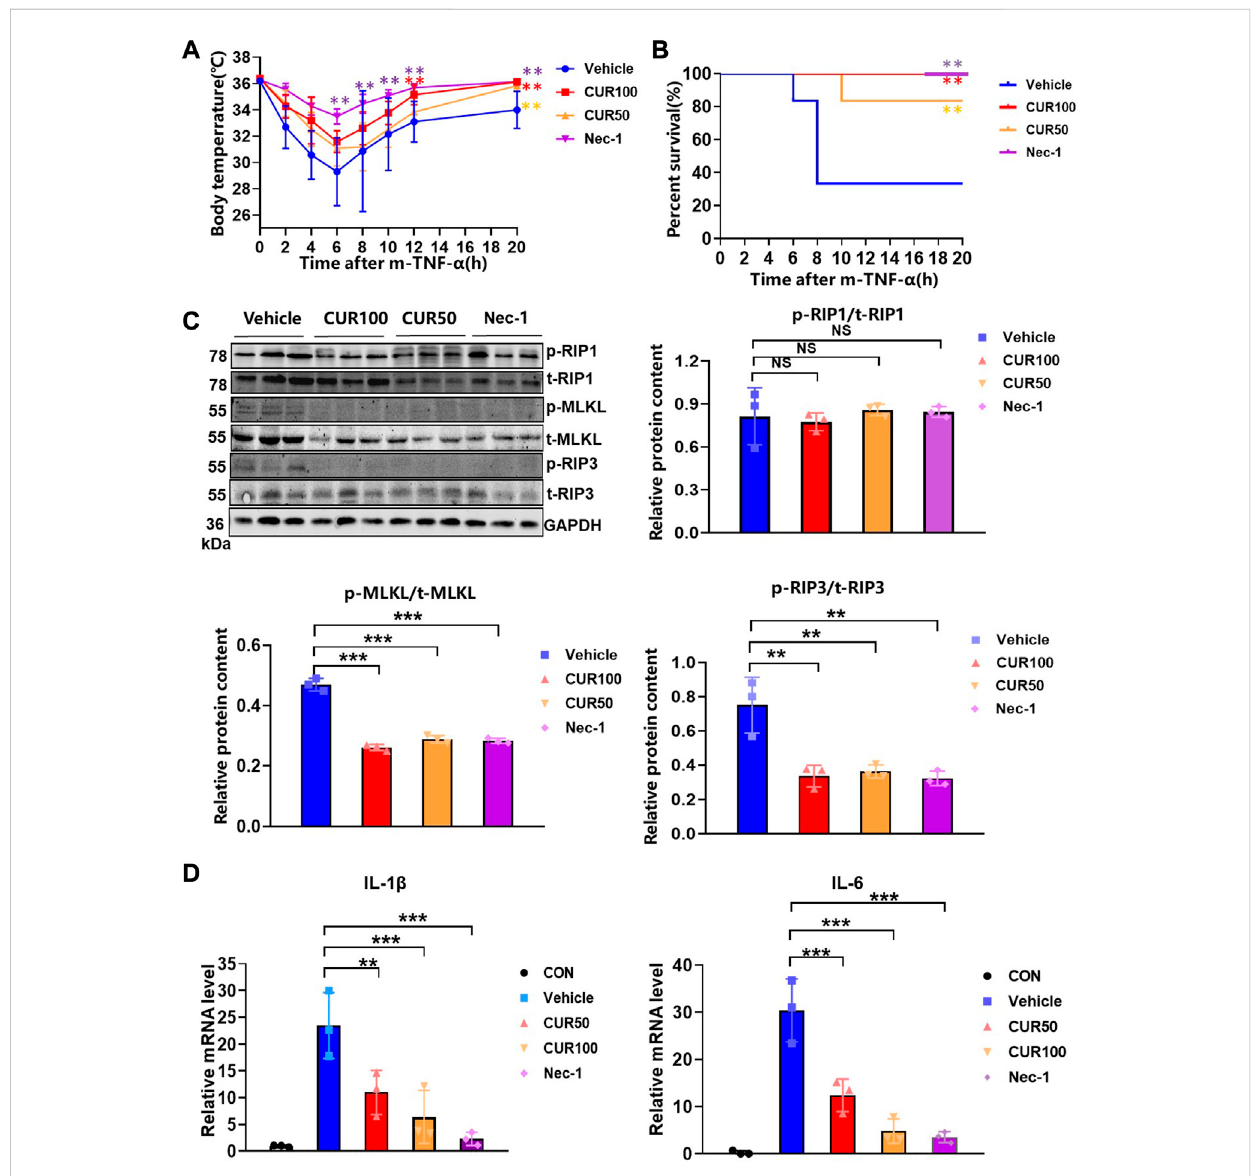
Curcumin potently inhibited systemic in fl ammatory responses initiated by the necroptosis signaling pathway in an in vivo model. (A) Body temperature of C57BL/6 mice (n = 6) injected with m-TNF- α (65 μ g/kg) and z-VAD-fmk (250 µg) after treatment with indicated doses of curcumin (100 mg/kg) and the survival curves (B) . (C) The expression of necroptosis biomarkers in colon tissue was analyzed by Western blot. And quantitative analysis of gray scales of protein bands. (D) Quantitative analysis of in fl ammatory cytokine RNA in mouse colon tissue. (** p < 0.01, *** p < 0.001, compared with Vehicle